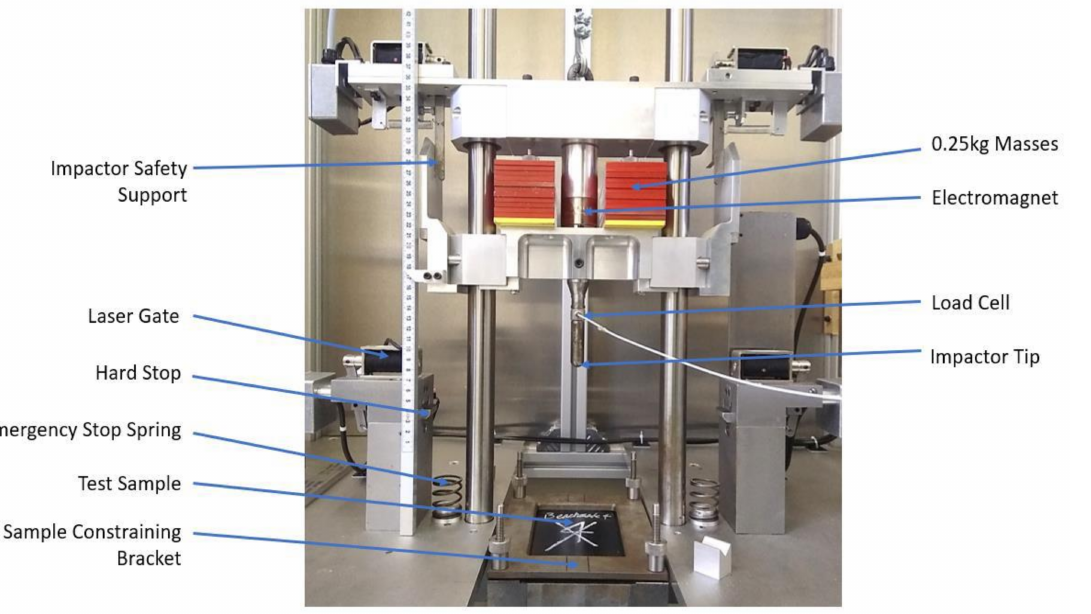
Figure 6. Impact rig used during the impact